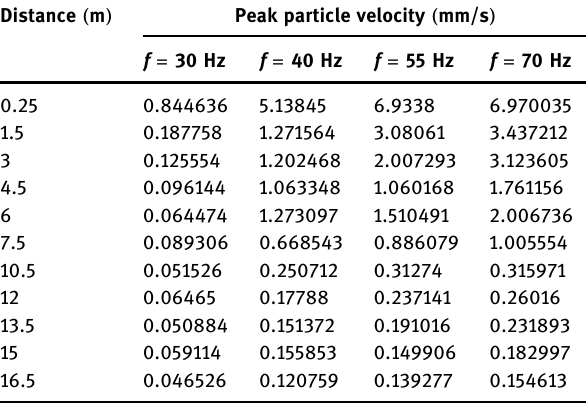
Table 11: The measured peak particle velocities at di ff erent loca - tions for various frequencies ( passive in - fi lled with 20% rubber trench barrier ) Distance ( m ) Peak particle velocity ( mm/s )